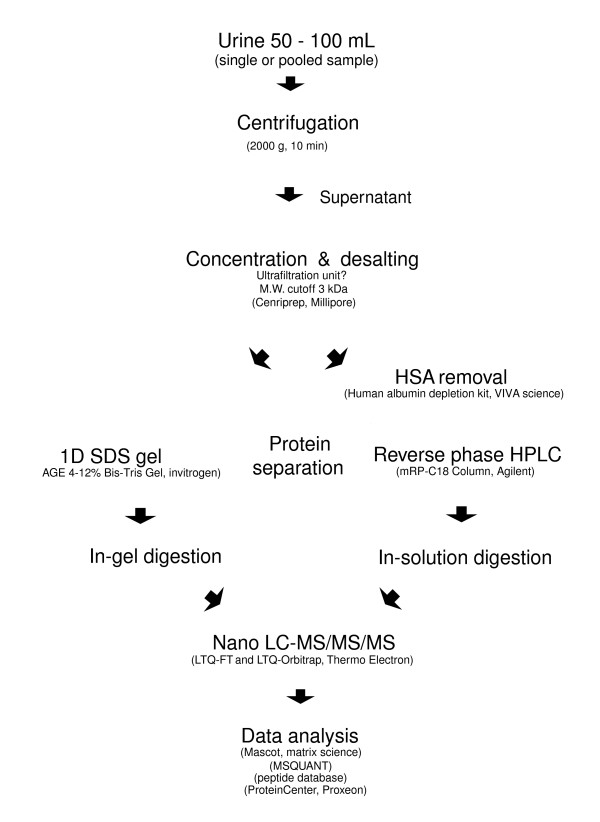
An overview of the procedure used for analysis of the urinary proteome. 1D, one-dimensional; HPLC, high-performance liquid chromatography; HSA, human serum albumin; MW, molecular weight; LC, liquid chromatography; MS, mass spectrometry; SDS, sodium dodecyl sulfate.